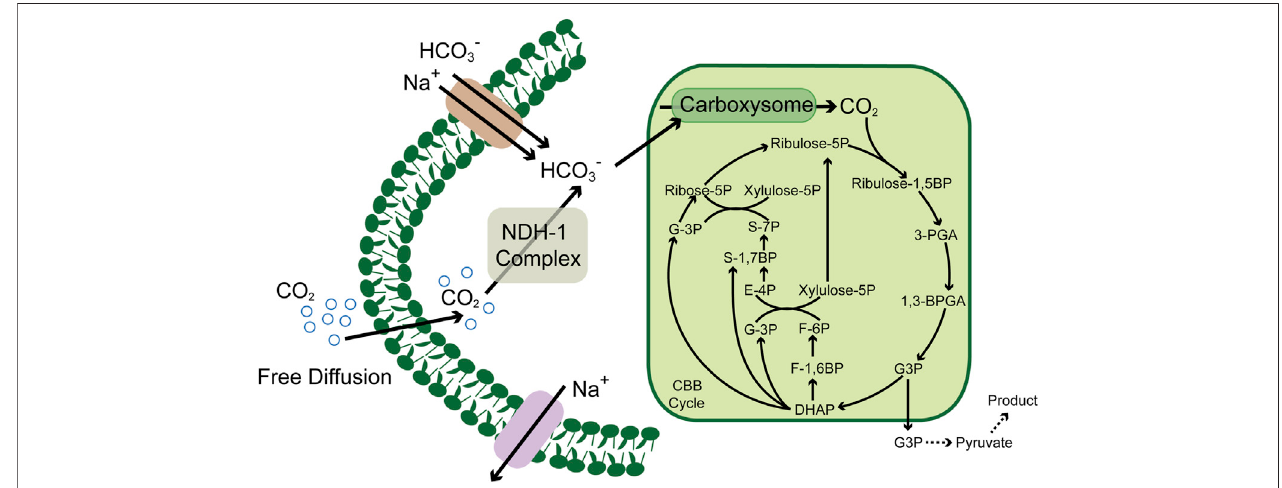
FIGURE 1 | Schematic of the carbon concentrating mechanism in cyanobacteria. CBB cycle, Calvin – Benson – Bassham cycle; ribulose-1, 5BP, ribulose-1, 5 diphosphate; ribulose-5P, ribulose-5 phosphate; ribose-5P, ribose-5 phosphate; 3PGA, glycerate 3-phosphate; 1, 3BPGA, 1,3-bisphosphoglycerate; G3P, glyceraldehyde 3 phosphate; DHAP, dihydroxyacetone phosphate; F-1, 6BP, fructose-1, 6 diphosphate; F-6P, fructose-6 phosphate; xylulose-5P, xylulose-5 phosphate; S-7P, sedoheptulose-7 phosphate; S-1,7BP, sedoheptulose-7 diphosphate; and E-4P, erythrose-4